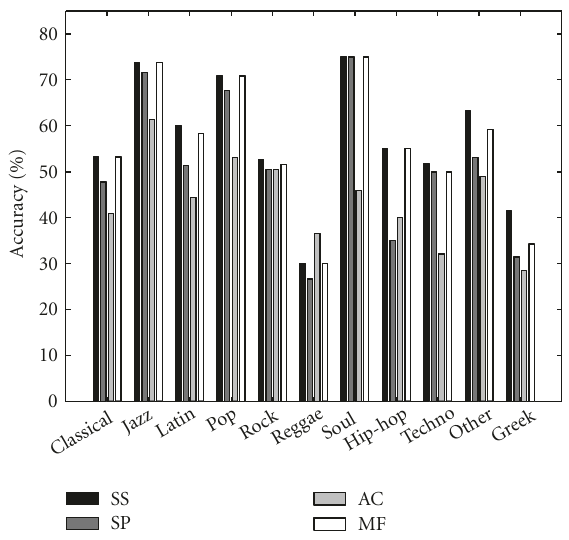
Figure 12: Operation point (5 seconds, 60% overlap) performance, Accuracy 1 .